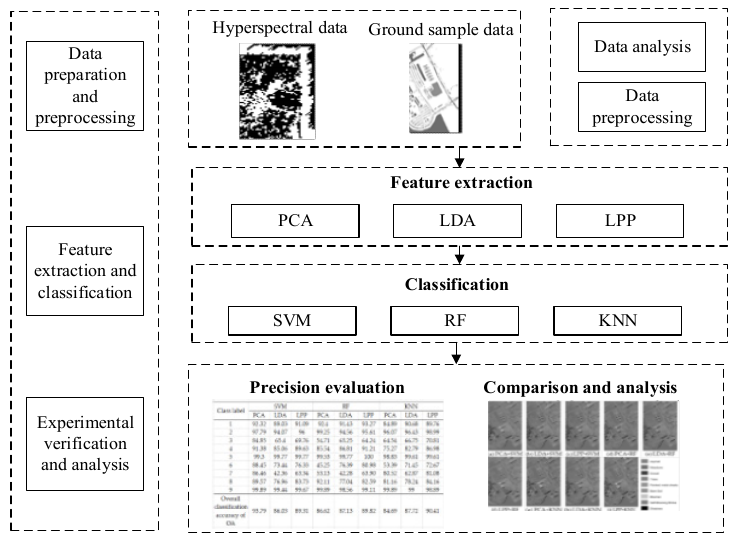
Figure 2. Technical